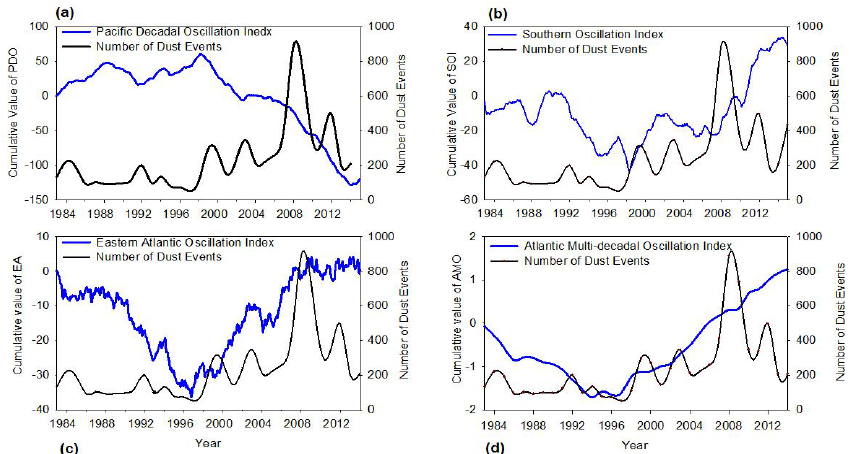
Figure 14. Relationship between climate Indices and dust frequency occurrence in Abu Dhabi City, ( a ) Pacific decadal oscillation index; ( b ) Southern oscillation index; ( c ) East Atlantic oscillation index; and ( d ) Atlantic multi-decadal oscillation index.